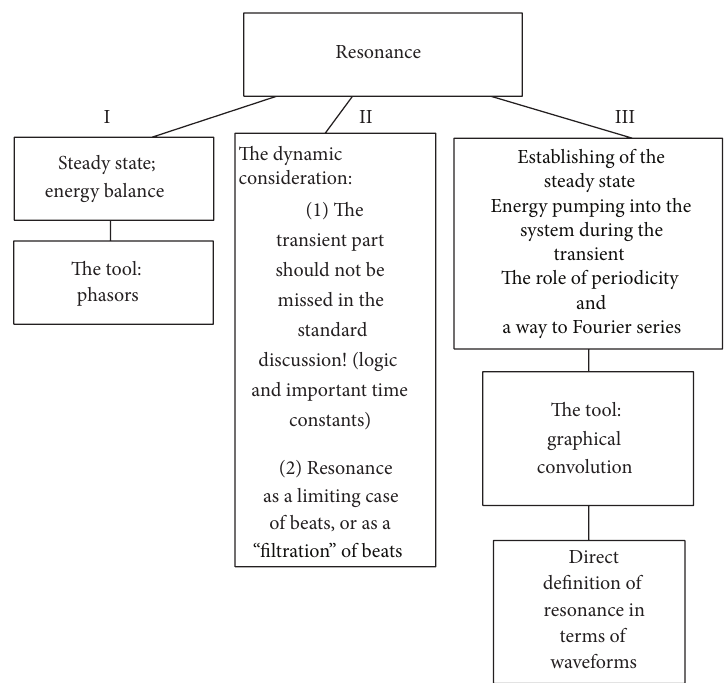
Figure 5: The methodological points regarding the study of resonance in the present